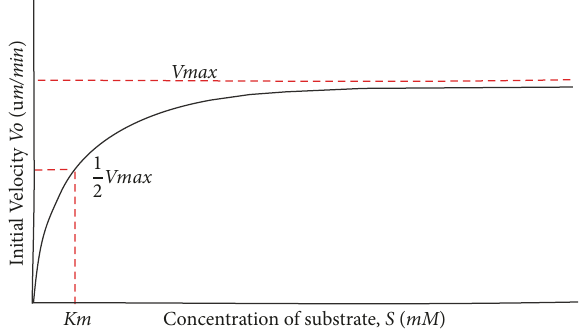
Figure 1: Enzyme kinetics: Michaelis-Menten